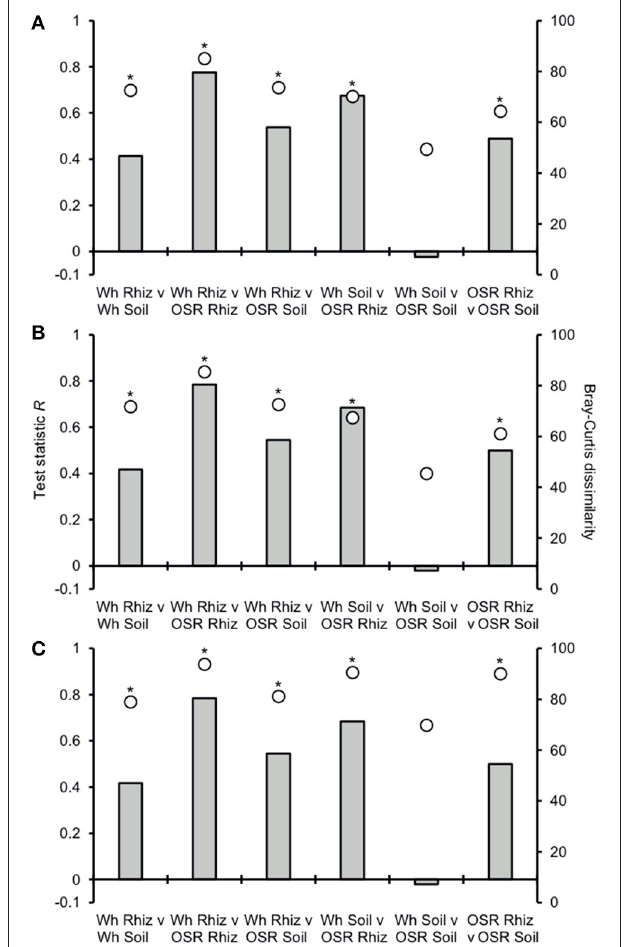
FIGURE 4 | Analysis of similarities (ANOSIM) and community dissimilarity between habitats for (A) all, (B) core, and (C) satellite plasmodiophorid OTUs. Given is the ANOSIM test statistic ( R , as columns) and probability ( P , asterisks) that two compared groups are significantly different at the P < 0.05 level (all significant differences were less than P < 0.0001). ANOSIM R and P values were generated using the Bray–Curtis measure of dissimilarity. R scales from + 1 to − 1. + 1 indicates that all the most similar samples are within the same groups. R = 0 occurs if the high and low similarities are perfectly mixed and bear no relationship to the group. A value of − 1 indicates that the most similar samples are all outside of the groups. Also given are the Bray-Curtis quantitative measures of dissimilarity between groups, denoted as